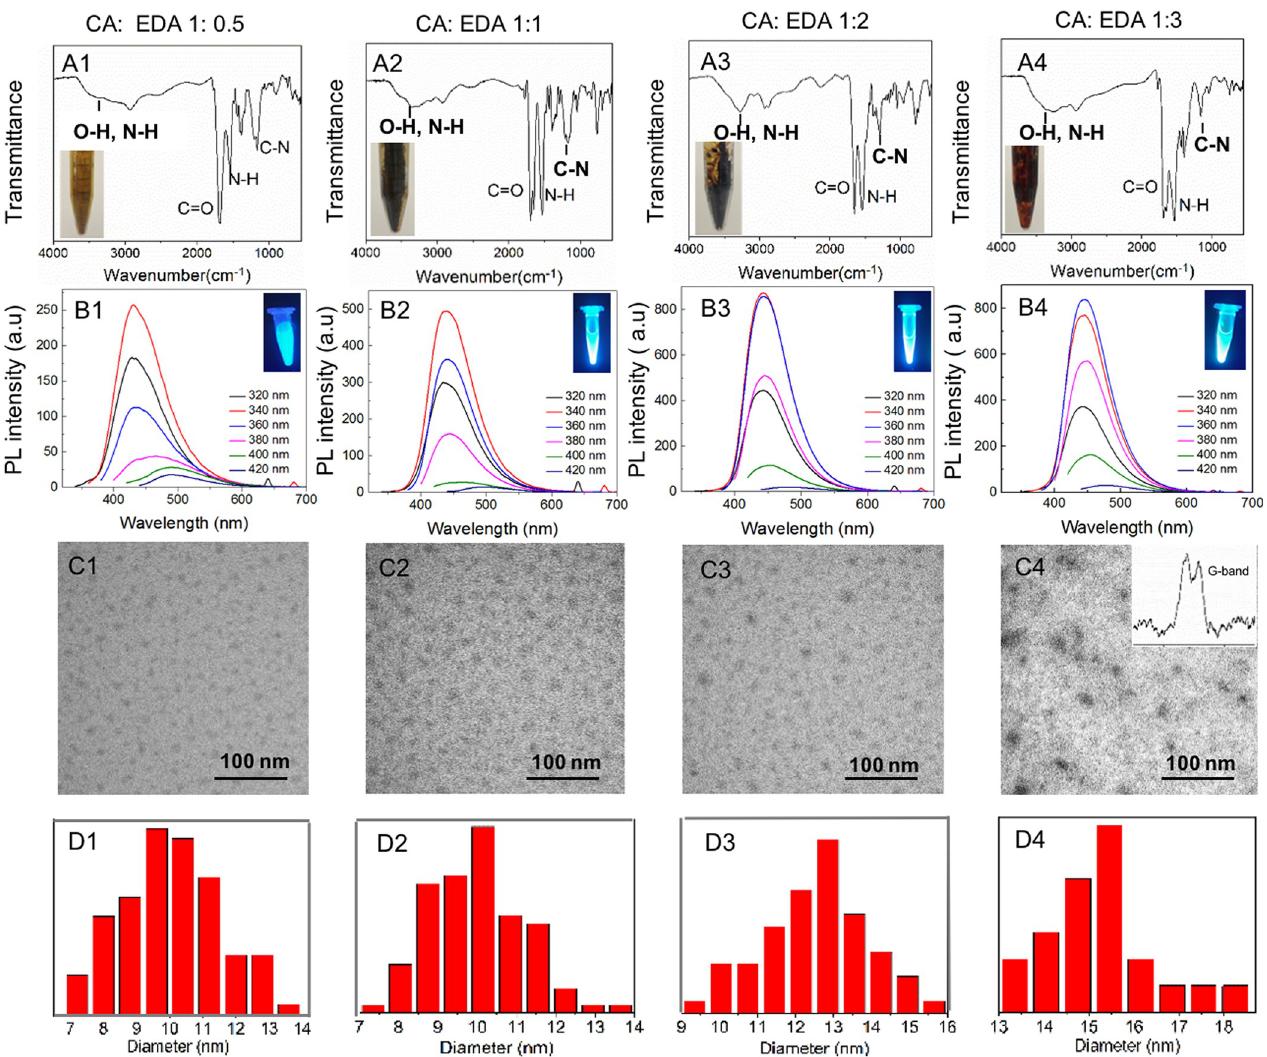
Fig 1. FTIR spectrum (A), fluorescent emission spectra at the same concentration (B), and TEM (C) of carbon dots made from different molar ratio of CA: EDA. The Raman spectrum of one sample is also included as inset in